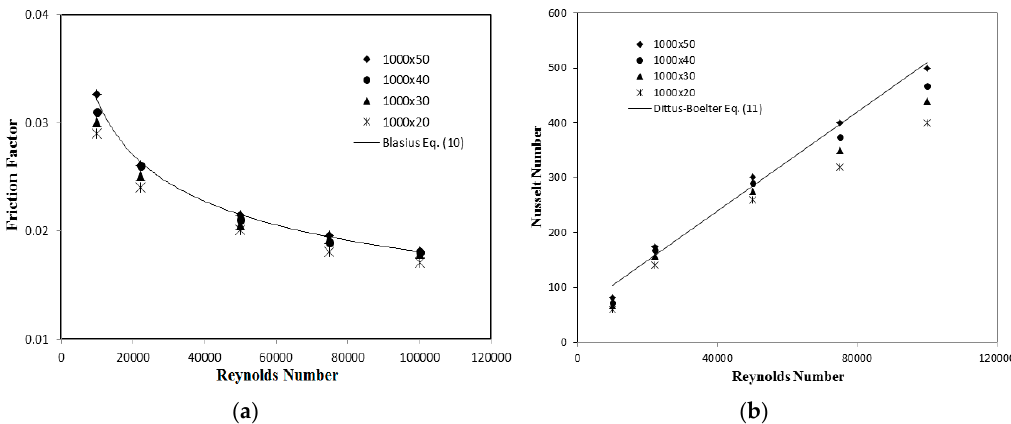
Figure 2. Meshing grid test. ( a ) Optimum mesh grid size fodscr friction factor with Reynolds number at 25 °C; ( b ) optimum mesh grid size of Nusselt number with Reynolds number at 25 °C.